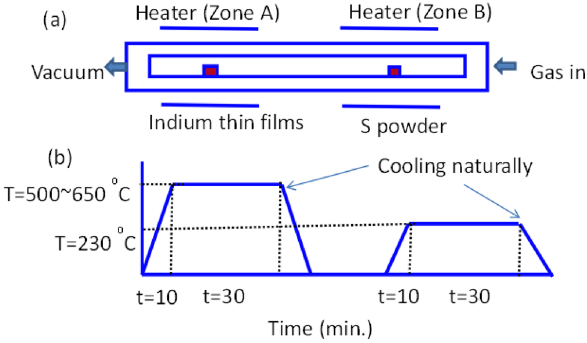
Figure 1. ( a , b ): ( a ) The two-zone furnace and ( b ) the temperature–time schedule diagrams for annealing the indium thin films in the sulfur environment at different pressures and temperatures to grow In 2 S 3 thin